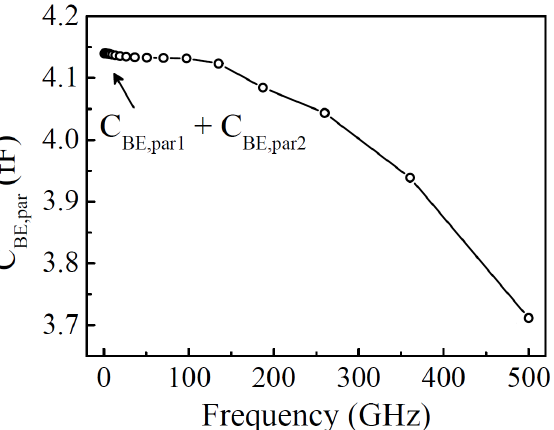
Figure 6. Frequency dependent capacitance characteristic for fbepar extraction following the cus- tomized TCAD structure shown in Figure 5.